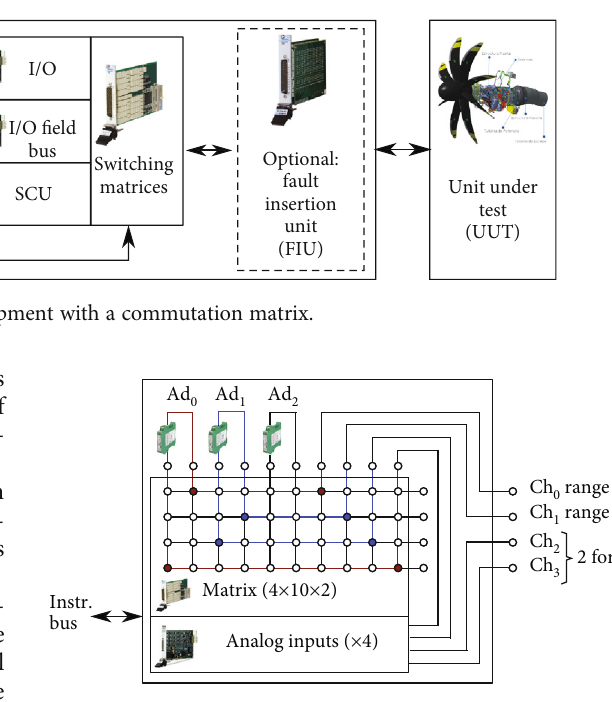
Figure 19: Example of using a matrix with a discrete